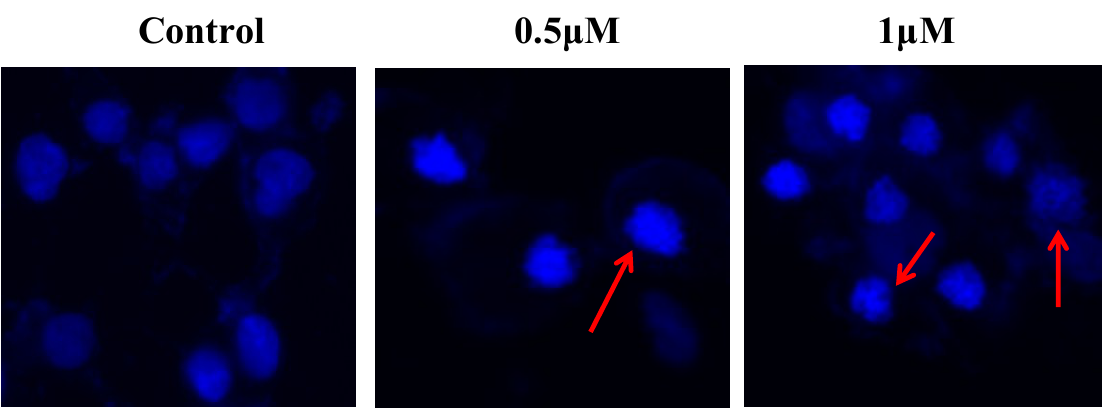
Figure 6. MCF-7 cells treated by 9f showed typical apoptotic morphologies.